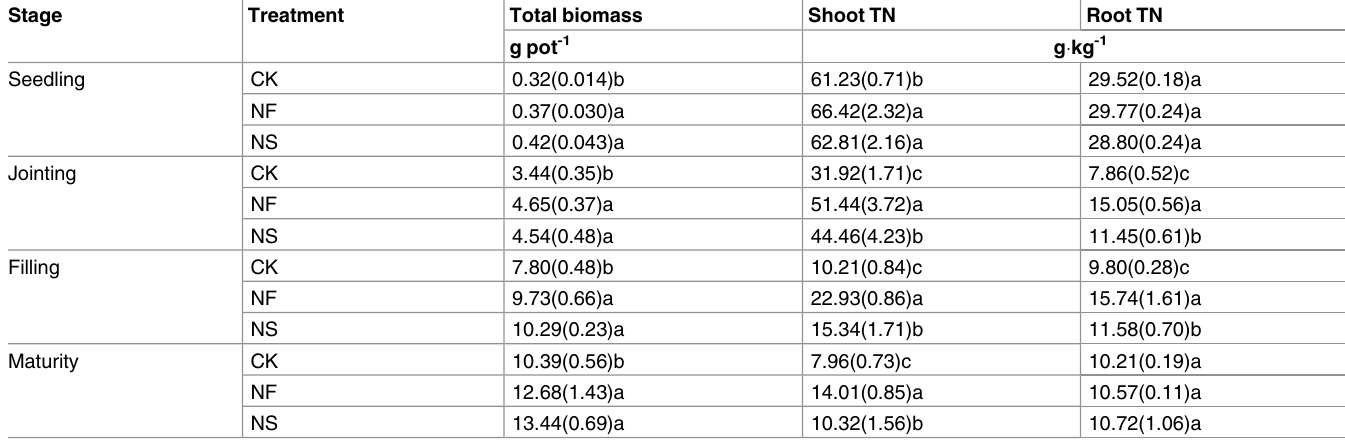
Table 2. Total wheat biomass and the Total N content at four sampling times under pot conditions (means ± S.D., n =